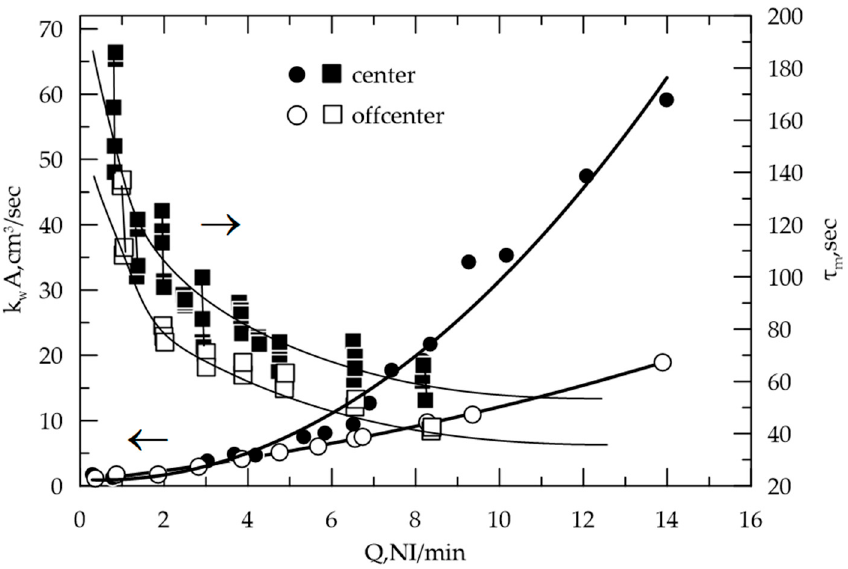
Figure 1. E ff ect of gas flow rate on both mixing time and the mass transfer coe ffi cient, comparing Figure 1. Effect of gas flow rate on both mixing time and the mass transfer coefficient, comparing central and o ff -central gas injection. Adapted from Kim and Fruehan central and off-central gas injection. Adapted from Kim and Fruehan [61].